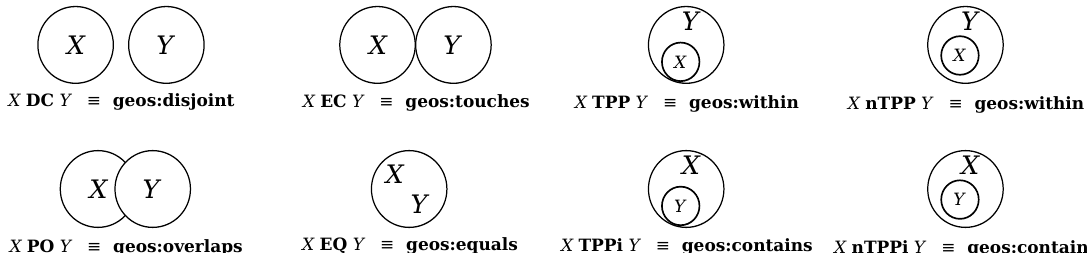
Figure 1. RCC-8 spatial relations defined in GeoSPARQL, where DC = disconnected, EC = externally connected, TPP = tangential proper part, nTTP = non-tangential proper part, PO = partially overlapping, EQ = equal, TPPi = tangential proper part inverse, nTTPi = non-tangential proper part